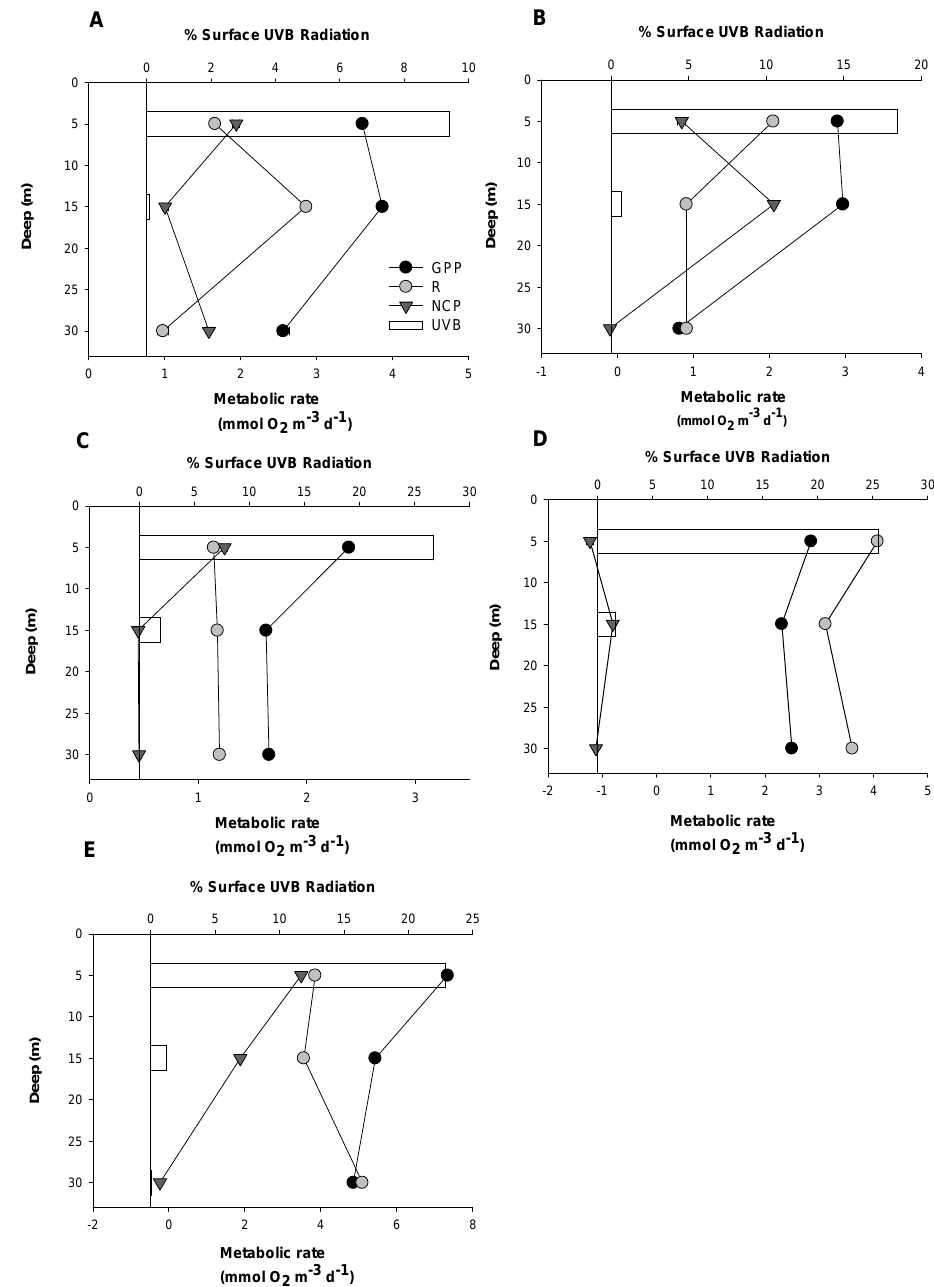
Fig. 4. Vertical profile of planktonic metabolic rates (mean ± SE for GPP, R and NCP) and the percent UVB irradiance reaching to the sampling depth at each of the open ocean stations investigated (A: Valdivia; B: Concepcion; C: Valparaiso; D: Coquimbo; E: Caldera).